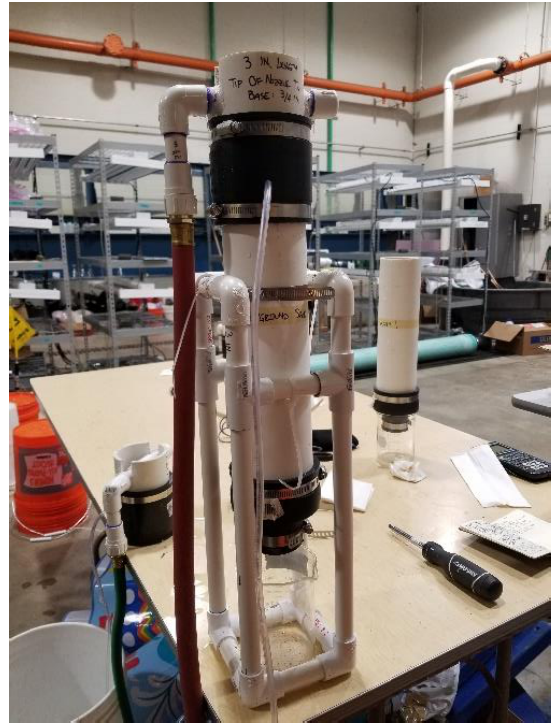
Figure 7. The complete soil column system.